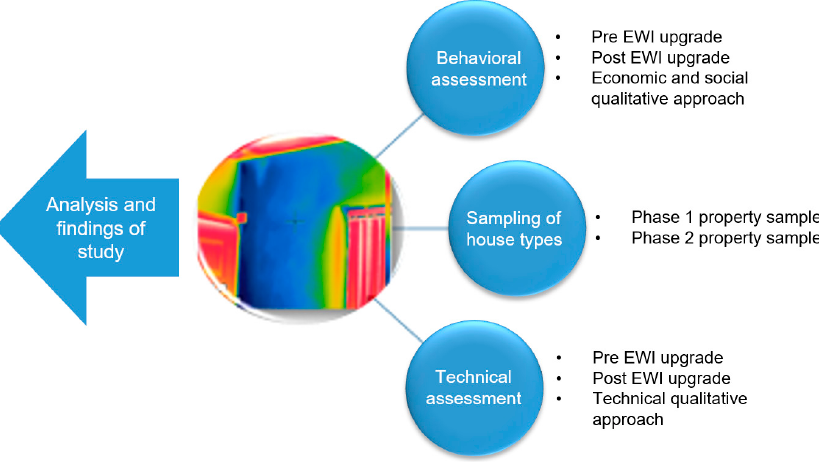
Figure 1. An overview of the methodology